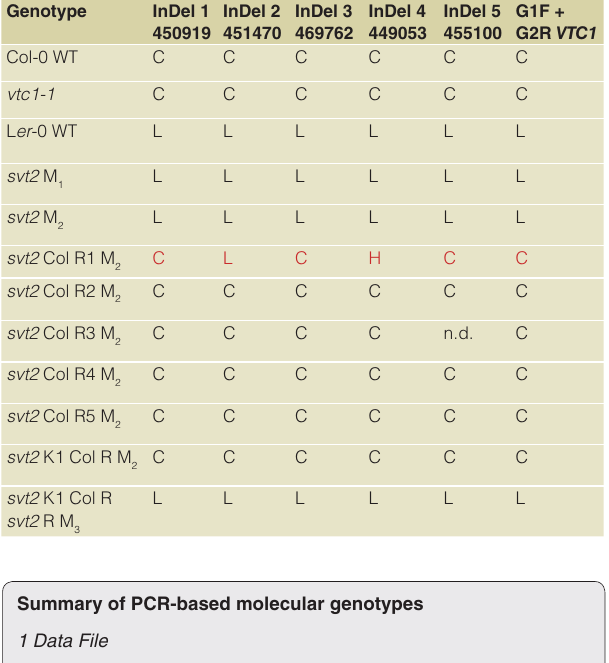
, svt2 Col R2 M , 3 3